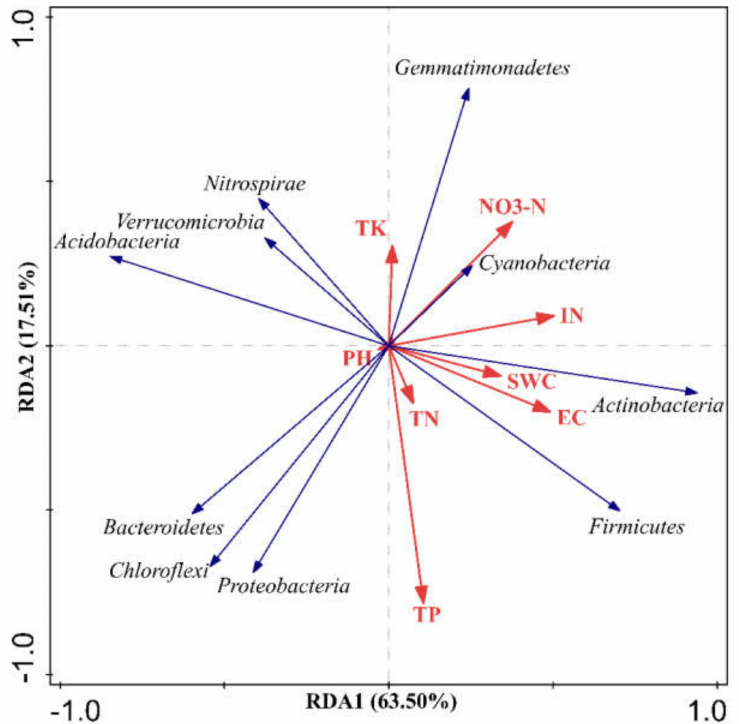
Figure 3. Redundancy analysis (RDA) of the composition of soil bacterial community at the phylum level and soil physiochemical properties. Bacterial phyla are represented by blue lines, and soil physiochemical properties (environmental factors) are represented by red lines. (TK: total potassium, NO 3 -N: nitrate nitrogen, IN: inorganic nitrogen, SWC: soil water content, EC: electrical conductivity, TN: total nitrogen, TP: total